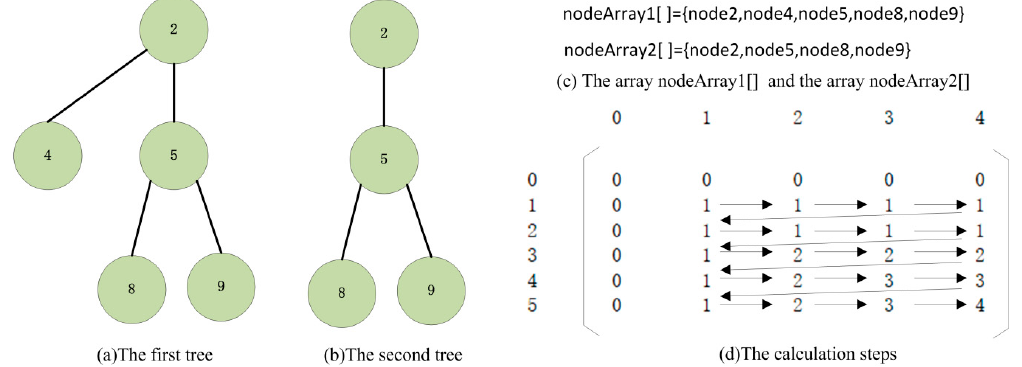
Figure 1. An example of the similarity analysis between two trees.